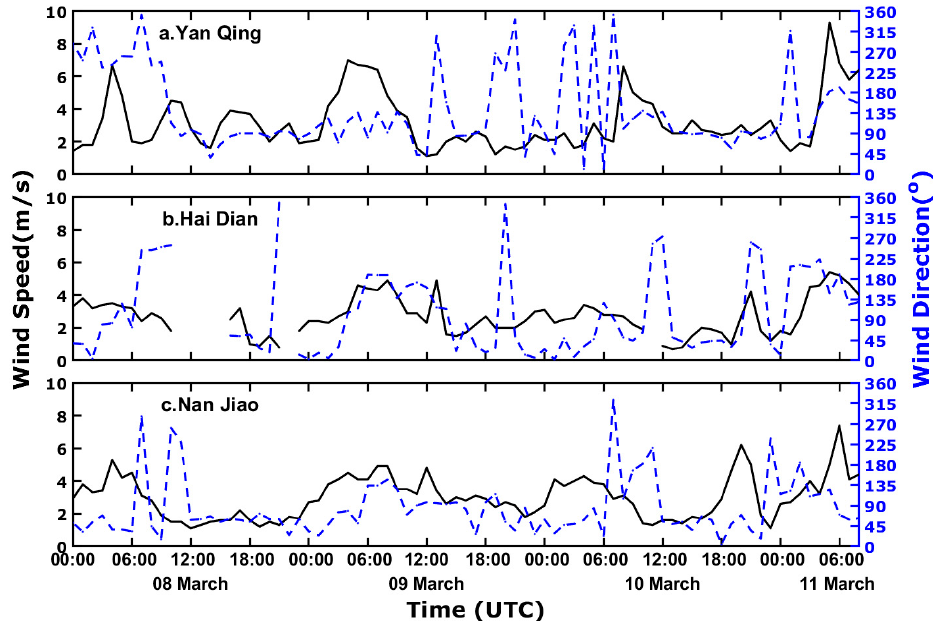
Figure 12. Wind speed and direction on the surface of each region (( a ) Yanqing, ( b ) Haidian, and ( c ) Nanjiao).